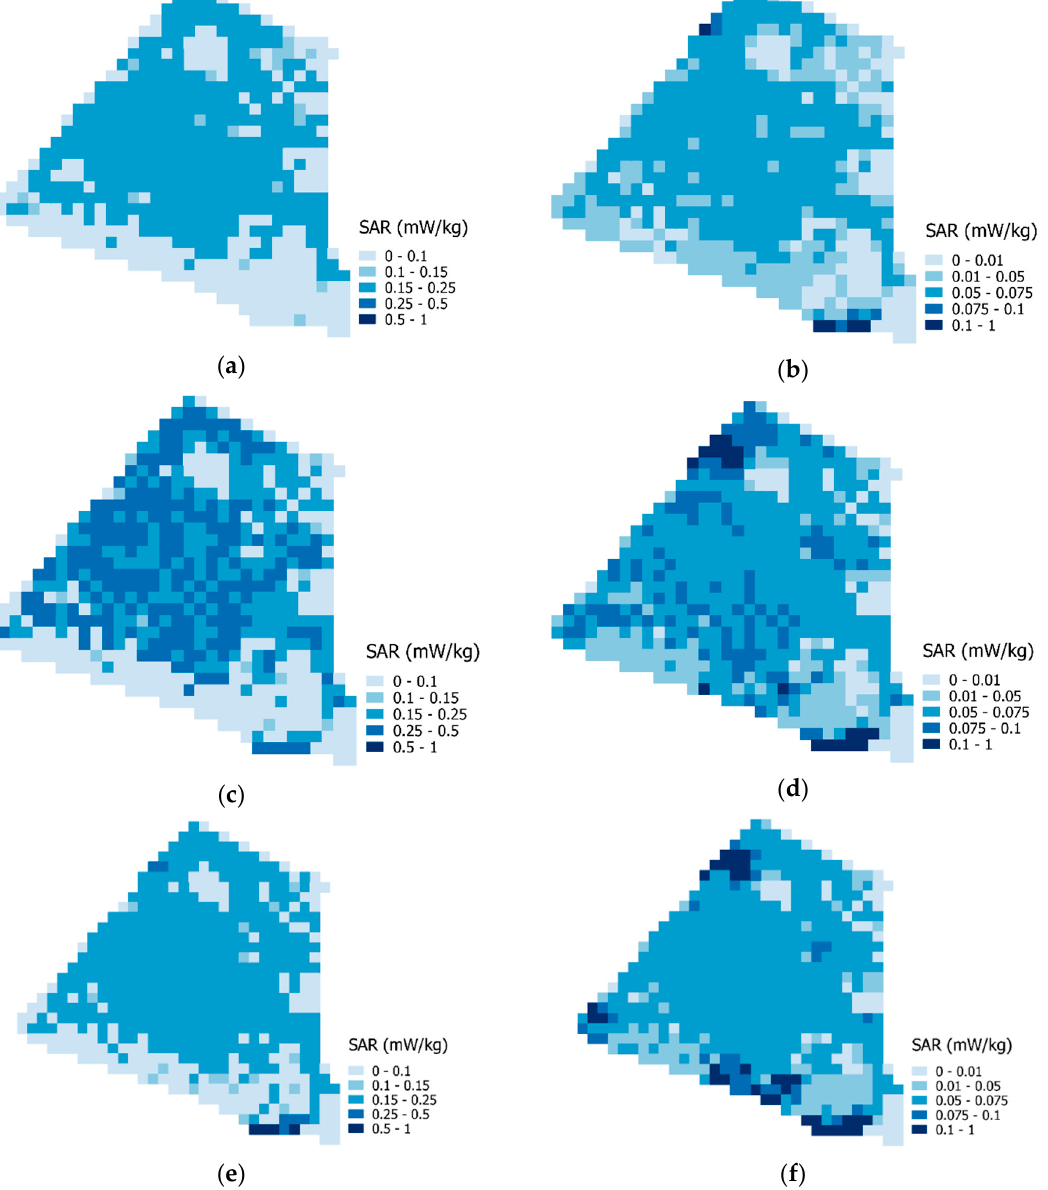
Figure 5. Radiofrequencies aggregated exposure maps (in SAR): ( a ) whole-body median percentile; ( b ) whole-brain median percentile; ( c ) whole-body mean; ( d ) whole-brain mean; ( e ) whole-body standard deviation; ( f ) whole-brain standard deviation. Each map portrays a statistical indicator that aggregates the exposure of all the people passing through the study area, weighted by the time they spend in there. For example, a value of 0.1 mW / kg in the top left panel indicates that it is the median of the whole-body exposure of all people that spend at least some time in that cell, weighted by the time they spend in there.